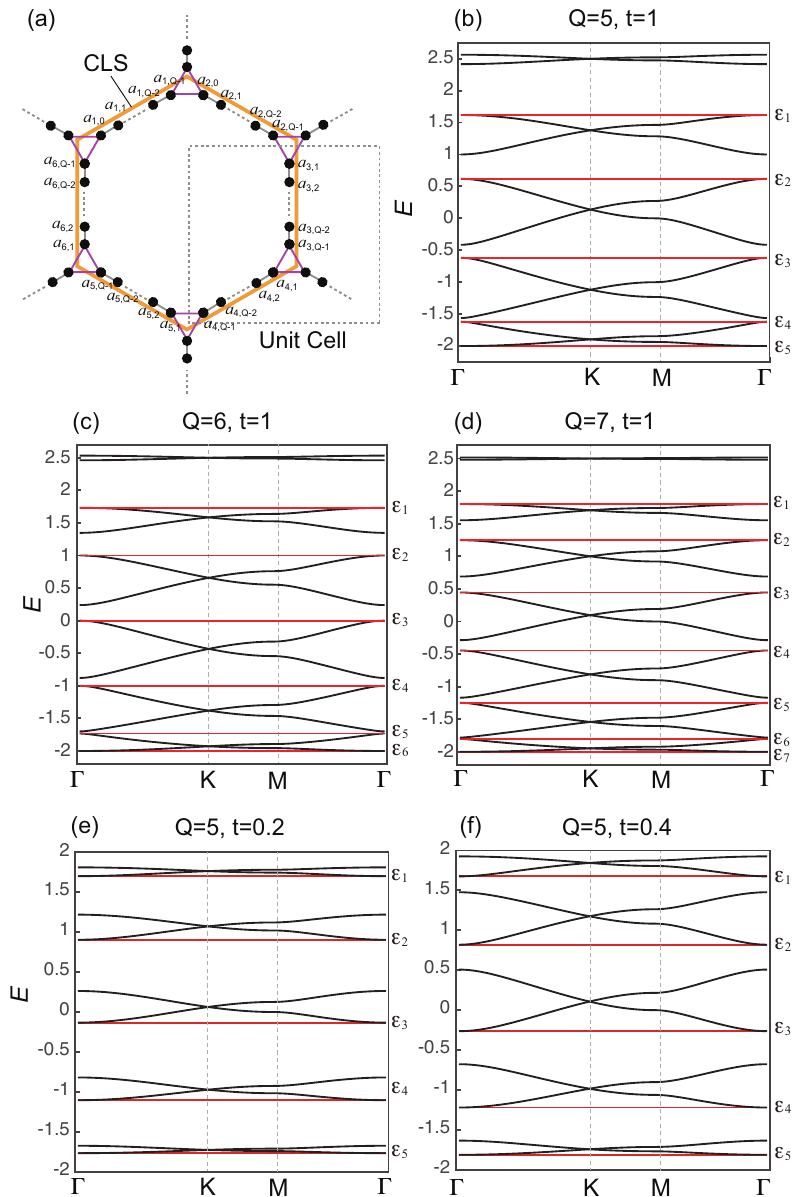
Figure 2. ( a ) The honeycomb network superstructure with the triangle-type links. The triangle- type links are colored purple. In the unit cell, there are 2 Q sites. The hopping parameter for the triangle-type link is denoted by t , while it is 1 otherwise. The yellow closed line represents the CLS. From ( b – d ), we plot band spectra with t = 1, while we consider t (cid:54) = 1 cases in ( e , f ). Flat bands are represented by red